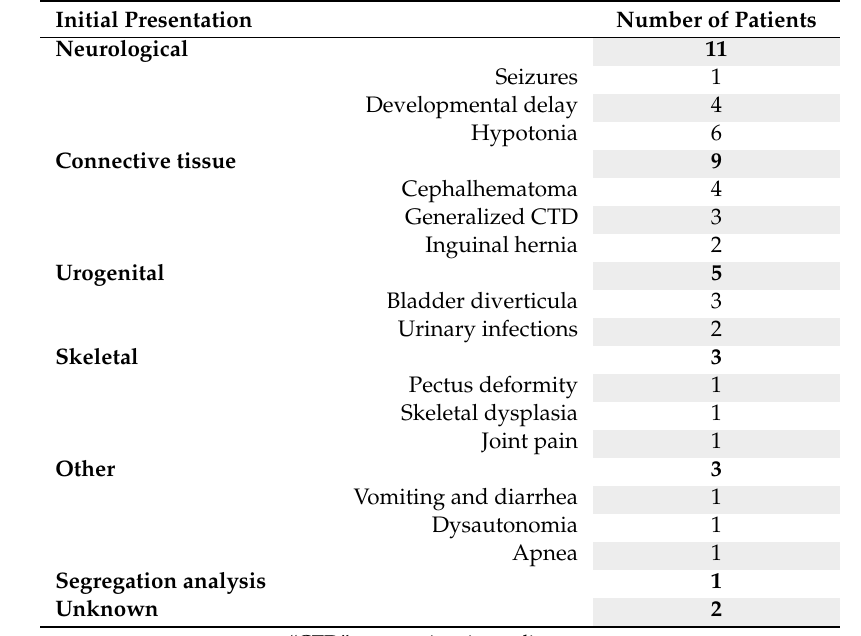
Table 2. Initial presentations leading to the diagnosis in occipital horn